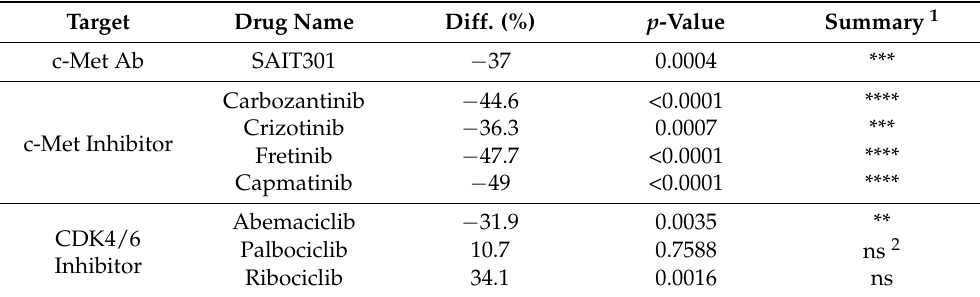
Table 1. Statistical value of AUC;measured intensity of c-Met protein, treating c-Met inhibitors and CDK4/6 inhibitors. Target Diff. (%) Summary 1